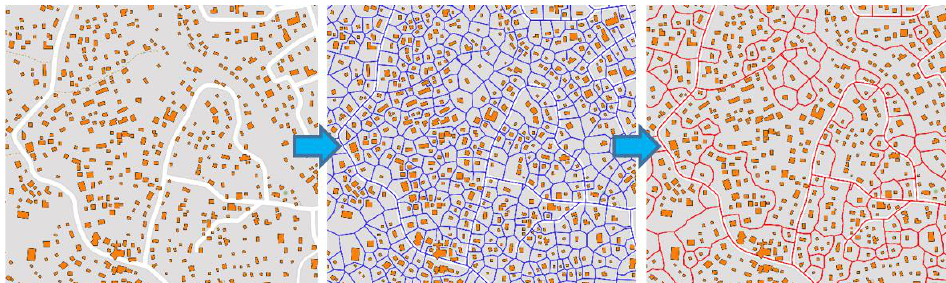
Figure 3. Generation of potential district boundaries and derivation of basic areas (basemap/buildings/polygons: [47]).